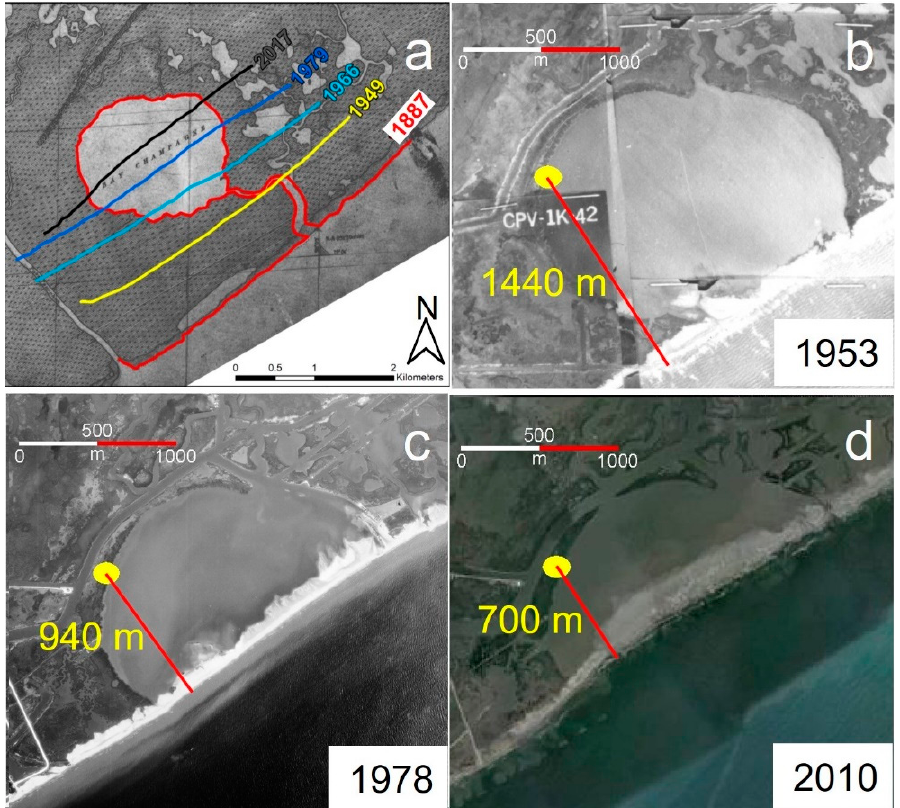
Figure 7. ( a ) Historic map (Dietz et al., 2022), ( b , c ) aerial photographs, and ( d ) satellite image showing rapid shoreline retreat at Bay Champagne since the late 19th century. The red lines perpendicular to the Shoreline show the distance between a fixed reference point (yellow circle) and the seaward edge of the beach on every satellite image. These lines were used as references to measure the shoreline retreat. Historic map and aerial photographs were retrieved from the Louisiana State University Cartographic Information Center.